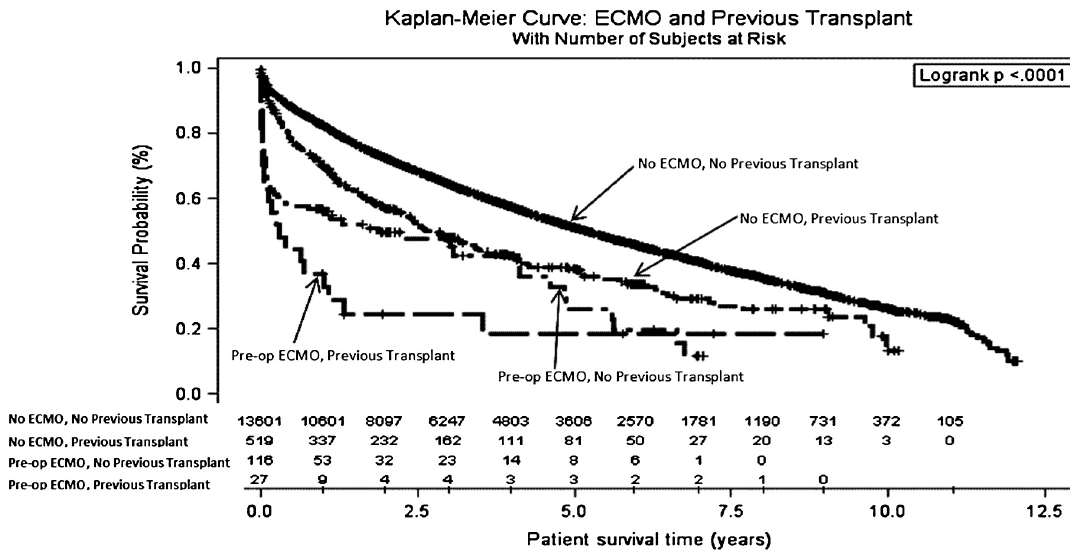
Figure 2. Kaplan – Meier Curve: Comparing survivals of patients on pretransplant ECMO with those that were not on ECMO who either had or did not have a previous